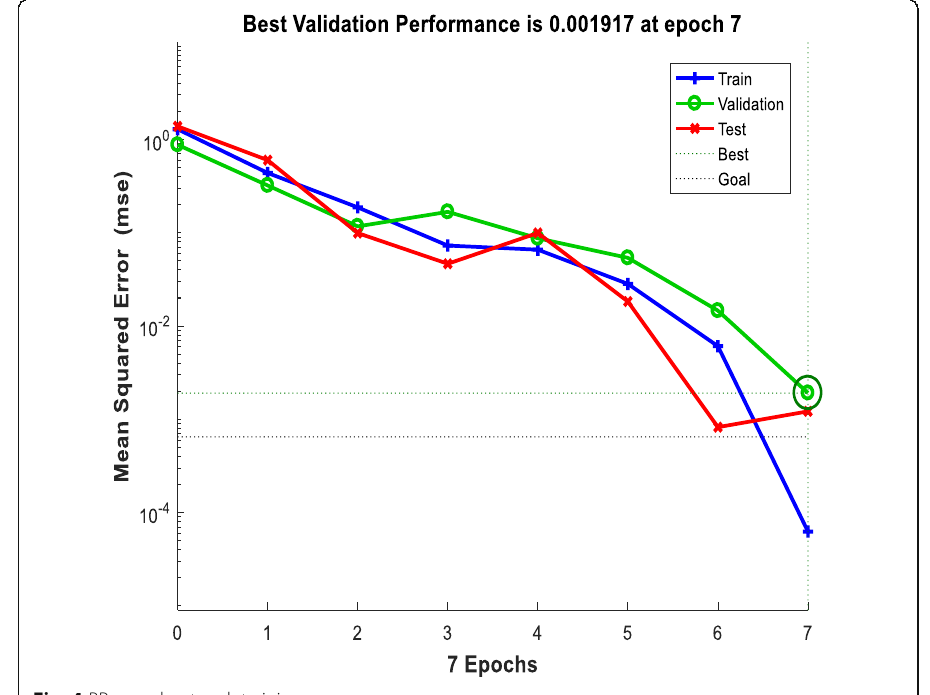
Fig. 4 BP neural network training error curve